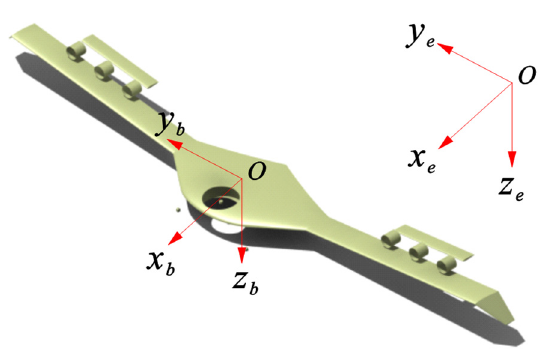
Figure 2. Bod y -axis coordinate system and earth axis coordinate system.